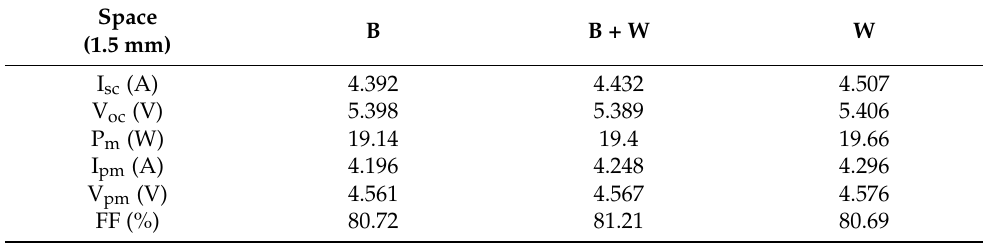
Table A2. The summary of MBB module operating test with various backsheets with 1.5 mm gap space.